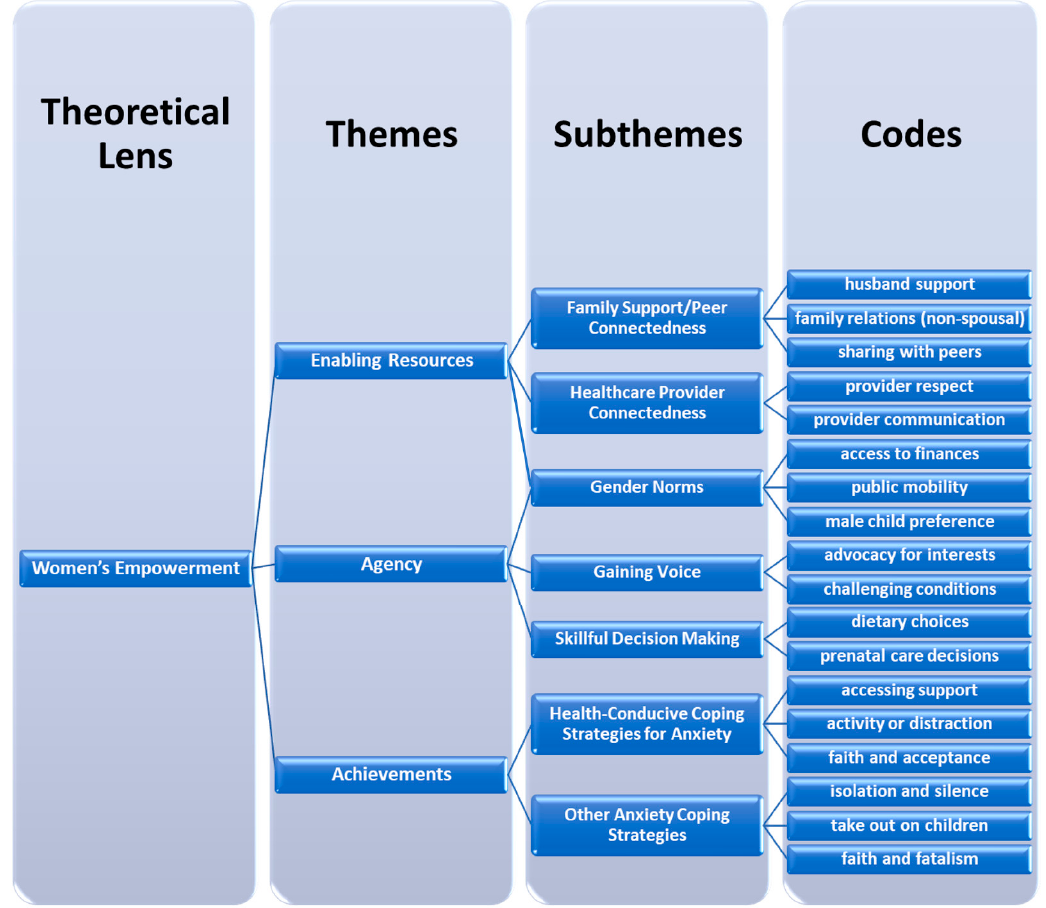
Figure 2. Schematized final codebook combining inductive, emergent codes with deductive, a priori themes from conceptual framework of pregnancy-related power.